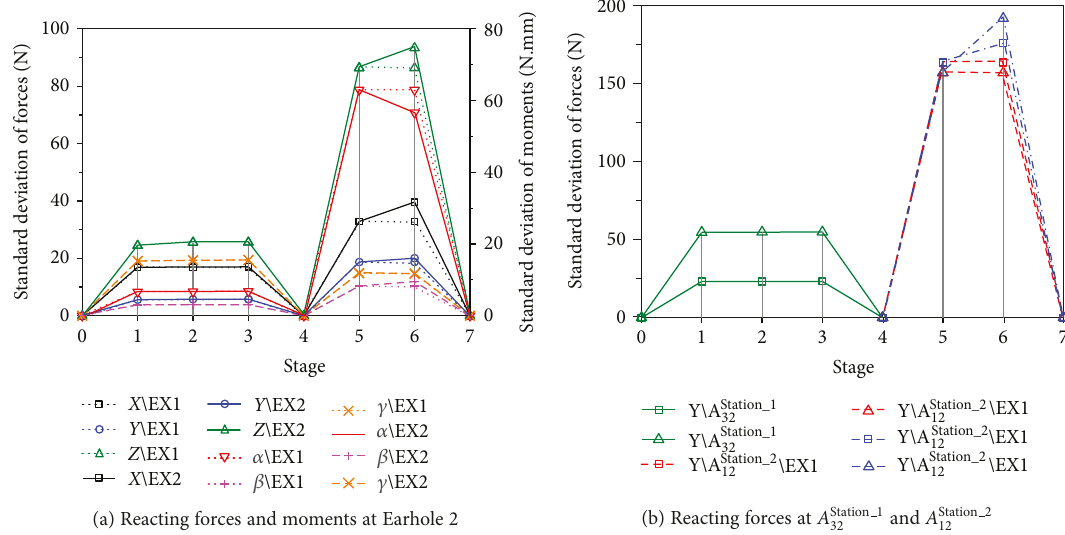
Figure 11: Standard deviations of reacting forces/moments by fi xture throughout the assembly